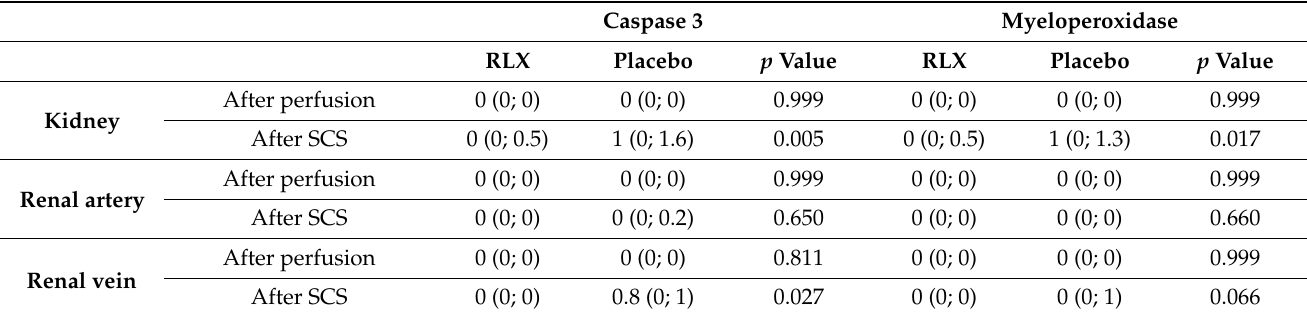
Table 2. Immunohistochemical evaluation for activated Caspase-3 positivity as well as Myeloperoxidase positivity in kidneys after perfusion and static cold storage in Placebo and Relaxin groups. Values are median (Quartile 1; Quartile 3). Caspase